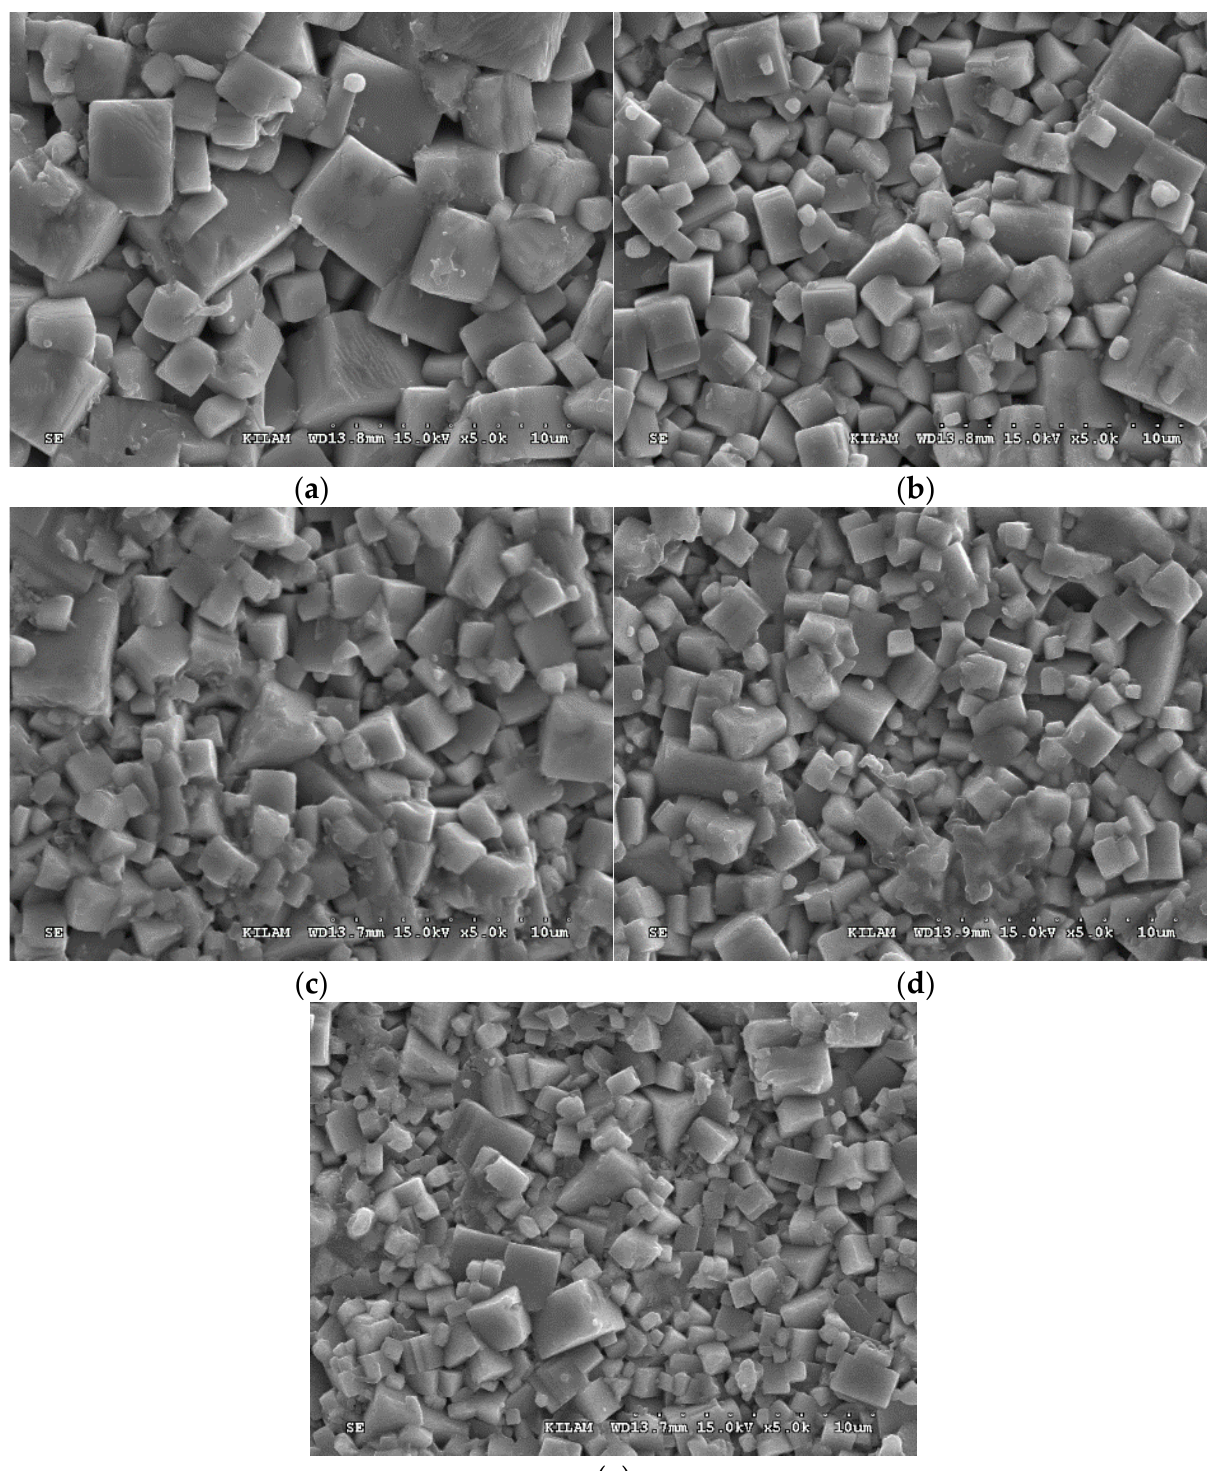
Figure 1. Scanning electron microscopy (SEM) of samples with the amount of antimony ( a ) x = 0.04, ( b ) x = 0.05, ( c ) x = 0.06, ( d ) x = 0.07, ( e ) x = 0.08.